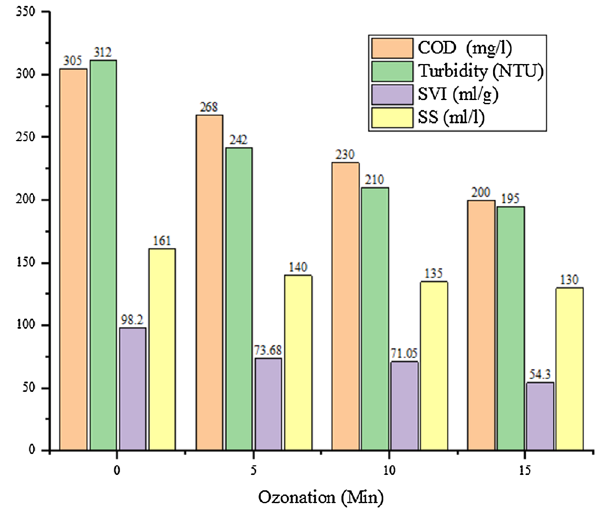
Fig. 5 COD, turbidity, SVI, and SS at different ozonation times (5, 10 and, 15 min) and comparison with raw wastewater (0 min or non- ozonation)